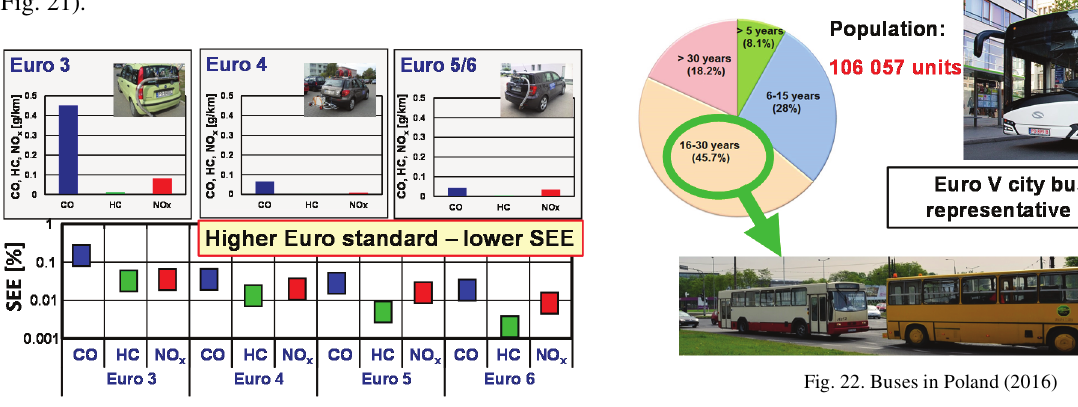
Fig. 20. Gasoline PC – standardization of exhaust emission